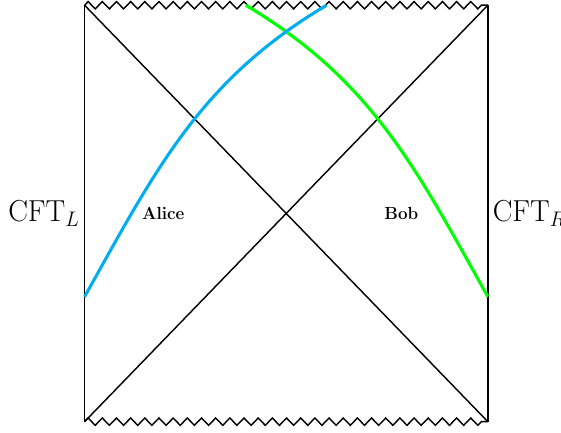
Figure 9: Alice and Bob travel from the left and right CFTs towards the